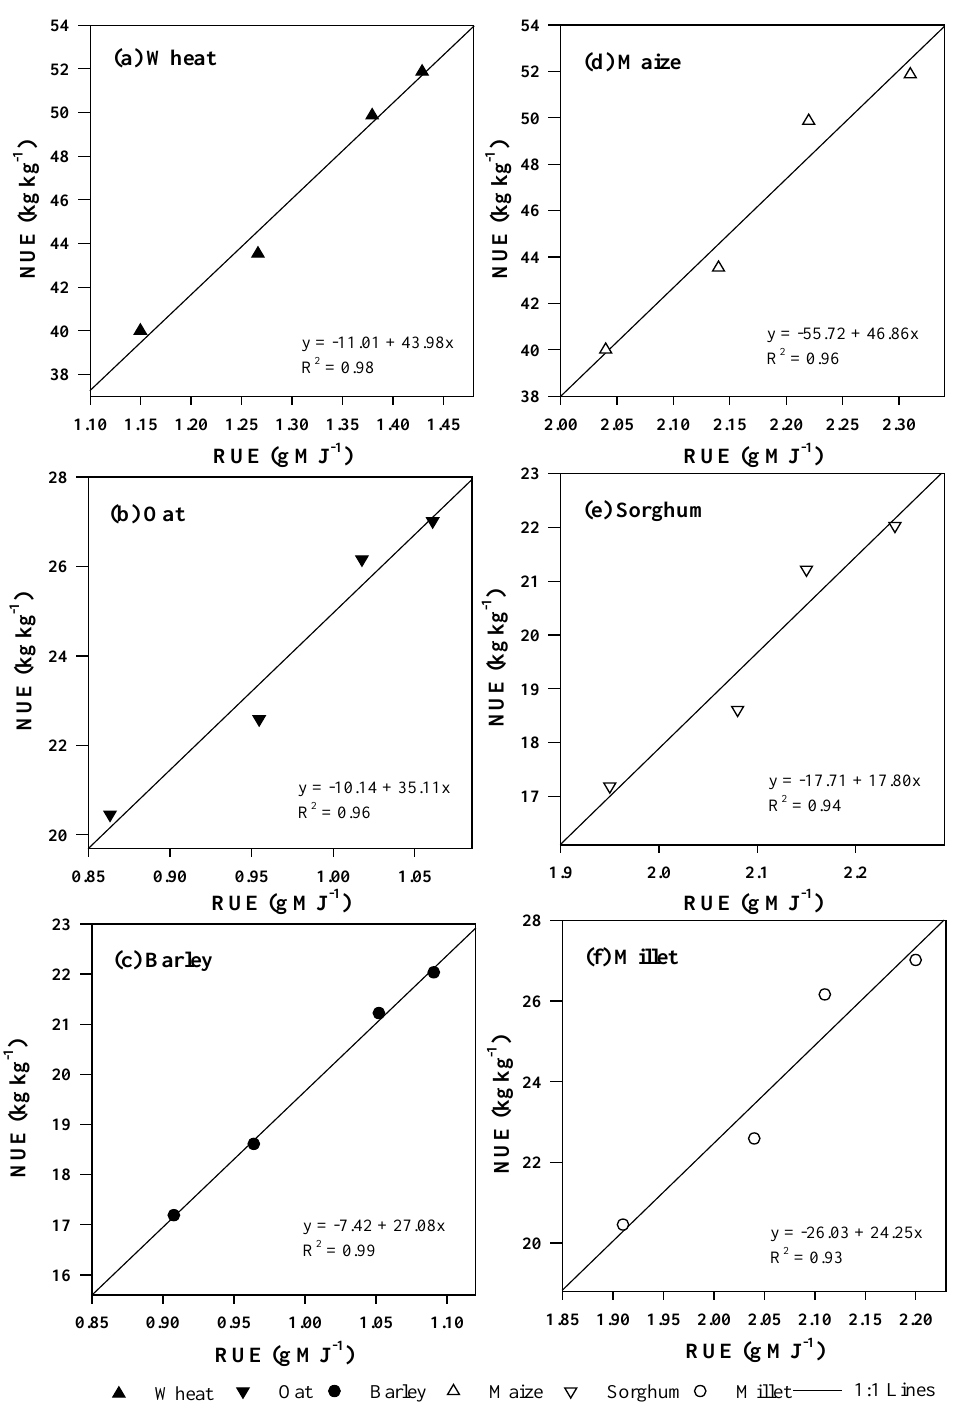
Figure 9. Relationship between RUE and NUE of C 3 winter ( a – c ) and C 4 summer ( d – f ) cereals at Multan, Pakistan.